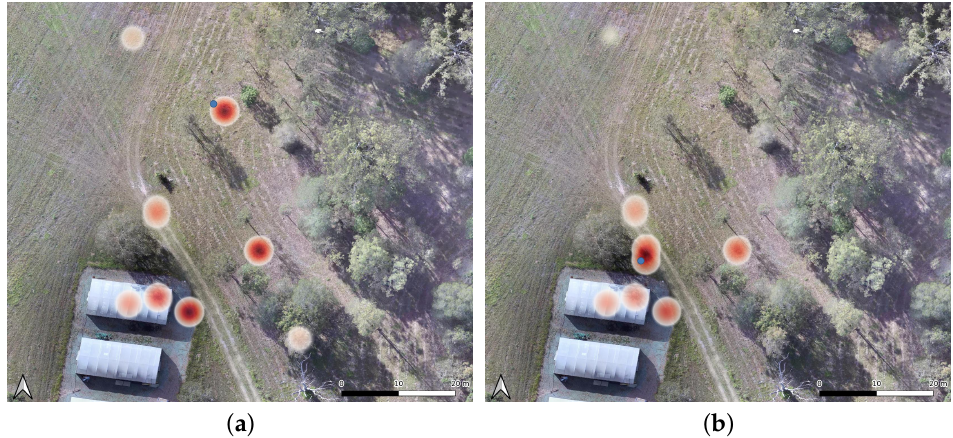
Figure 13. Heatmaps from recorded GNSS coordinate points from detections in mission mode. The amount of false positive locations were triggered by the CNN model from detecting other objects as people during the survey. ( a ) First victim location (blue dot) in an open area. ( b ) Second victim location (blue dot) nearby a tree.